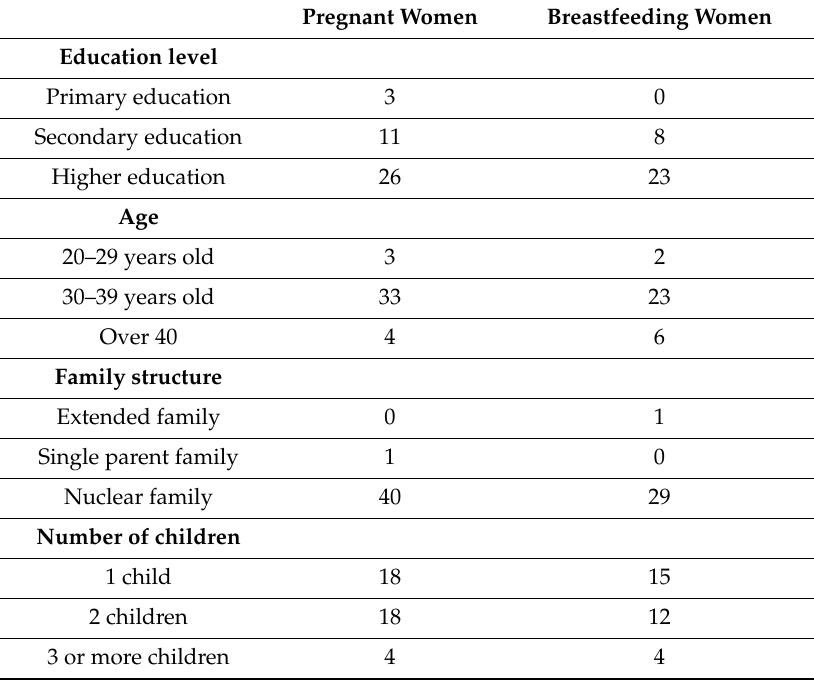
Table 1. Socio-demographic characteristics of the women who completed food